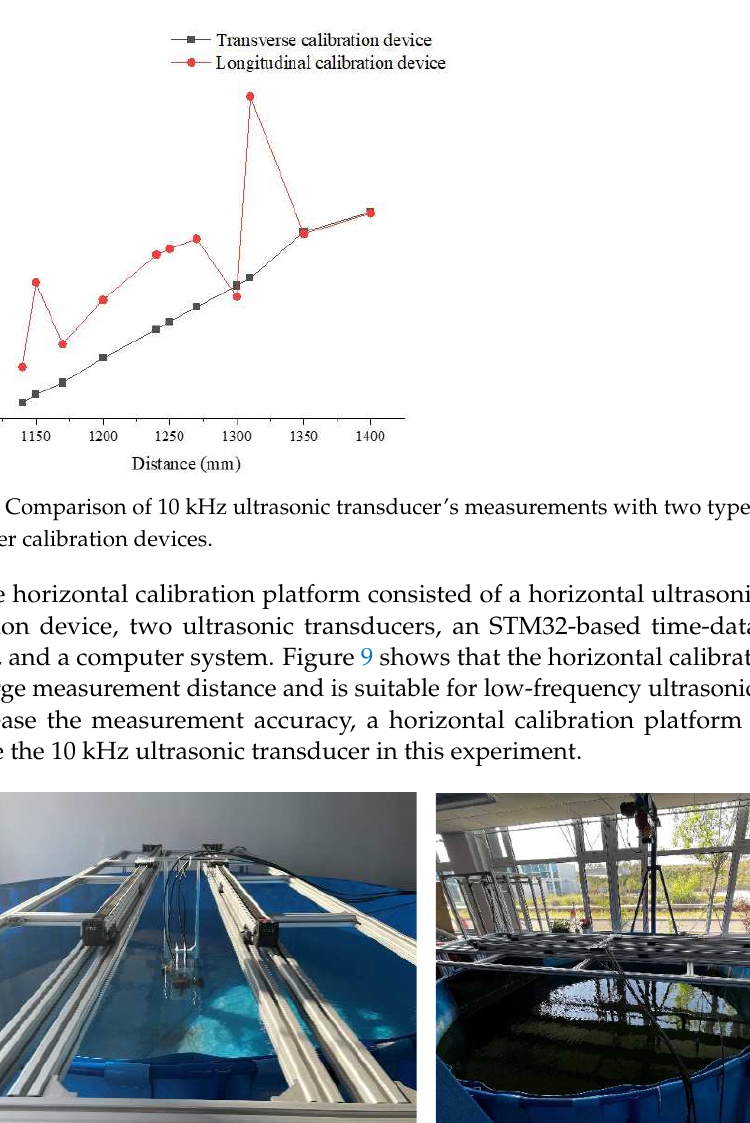
Figure 9. Error calibration platform for the transverse ultrasonic transducer.